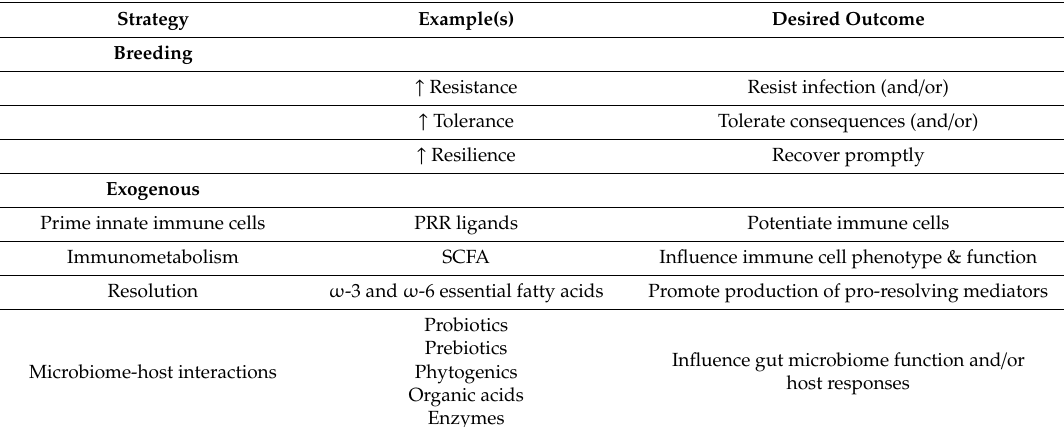
Table 2. Potential strategies to promote poultry gut